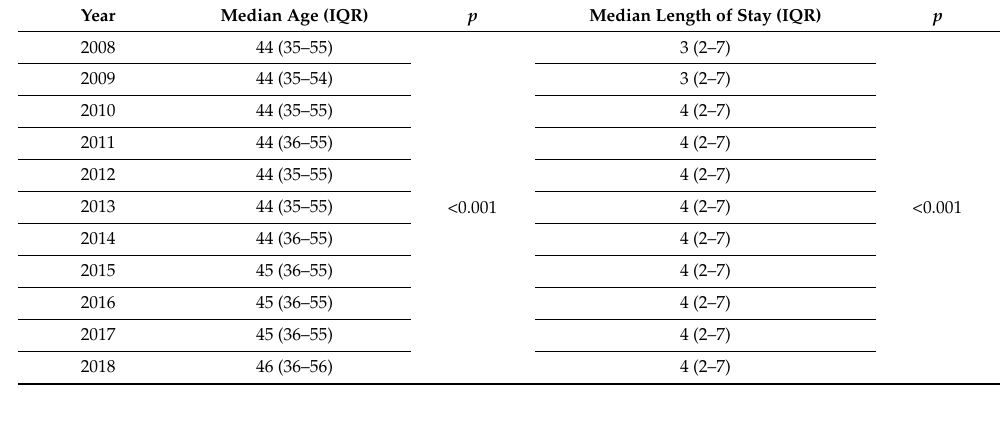
Table 3. Female patients’ median age and median regarding the length of hospital stay for cervical cancer during the years 2008–2018.